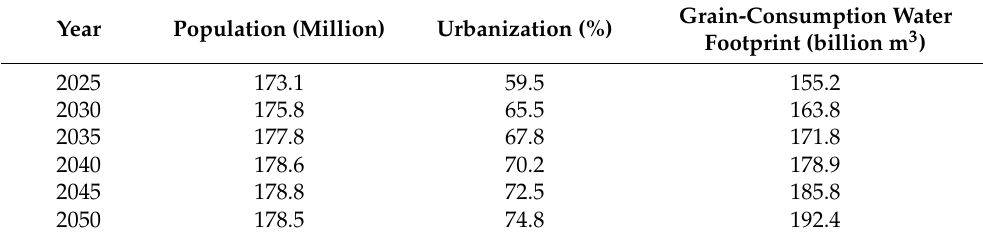
Table 2. Water-footprint projections for grain consumption in Northwest